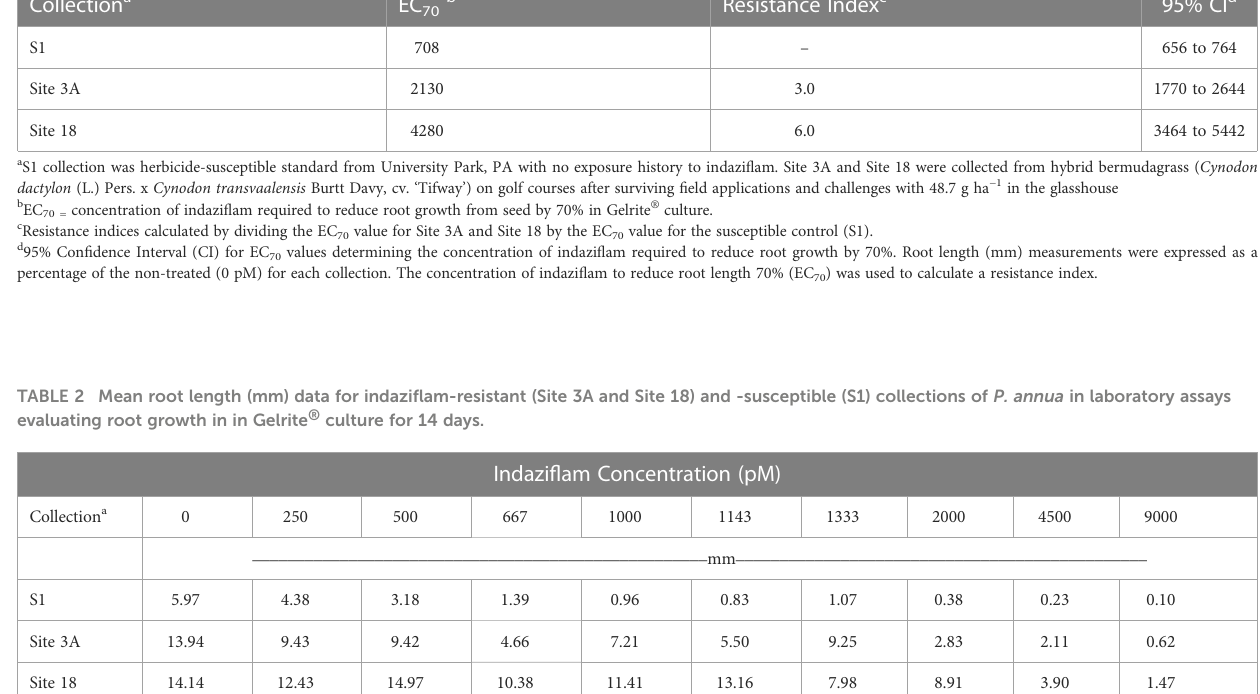
TABLE 1 P. annua collections subjected to increasing doses of indazi fl am (0, 250, 500, 667, 1000, 1143, 1333, 2000, 4500, and 9000 pM) in Gelrite ® culture for 14 days. Collection a